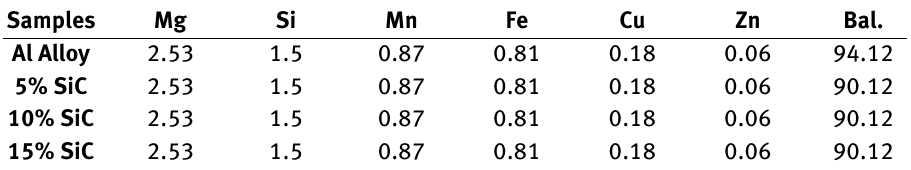
Table 1: Al alloy ingot chemical composition that prepared from Al sandwich panel plates Elements Al Mg Si Mn Fe % Table 2: Composition of samples prepared for this study Samples Mg Si Mn Fe Cu Zn